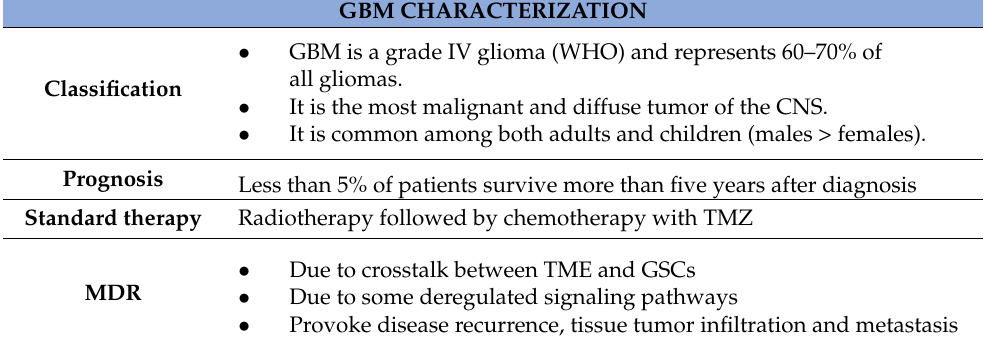
Table 1. Main features of glioblastoma (GBM) classification, prognosis and